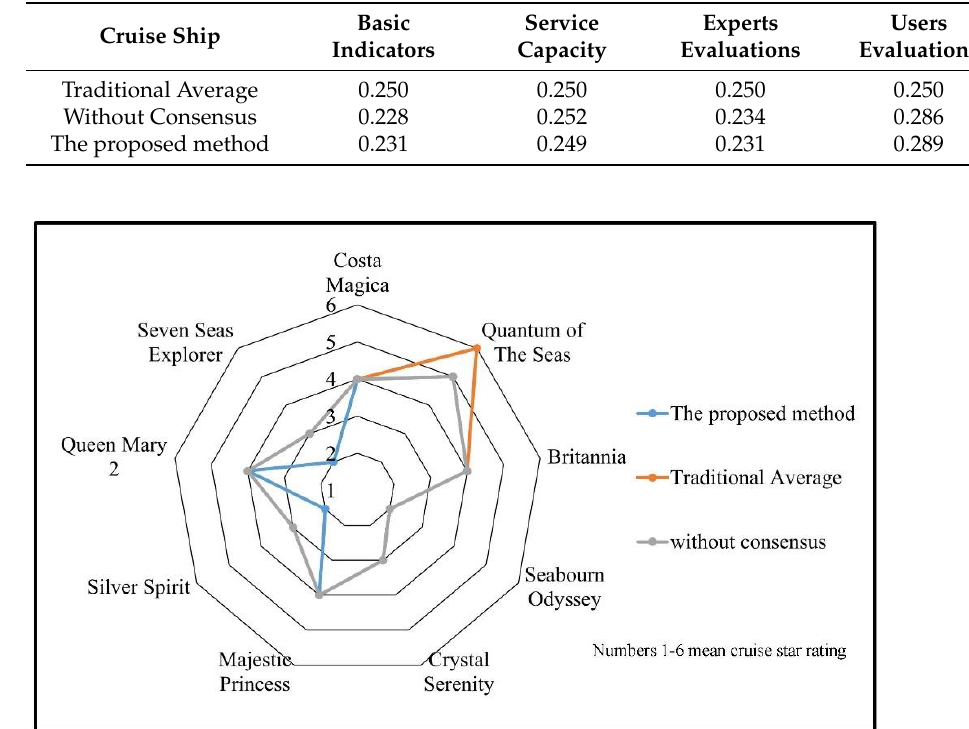
Figure 3. The results comparison of cruise star rating under different method.